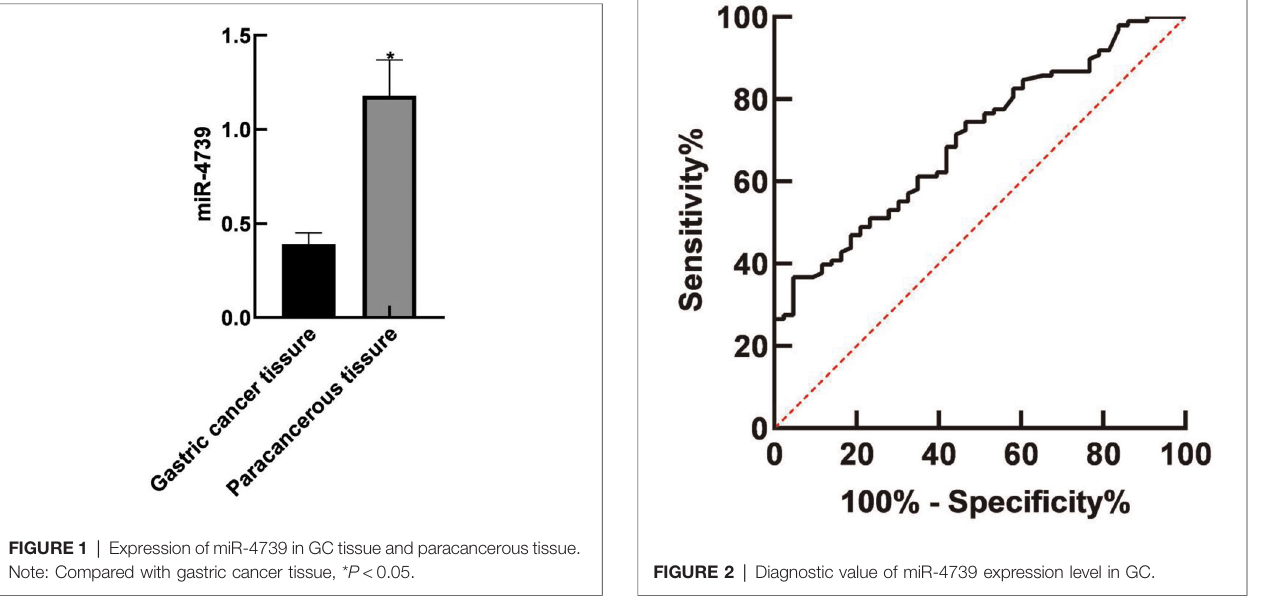
FIGURE 2 | Diagnostic value of miR-4739 expression level in